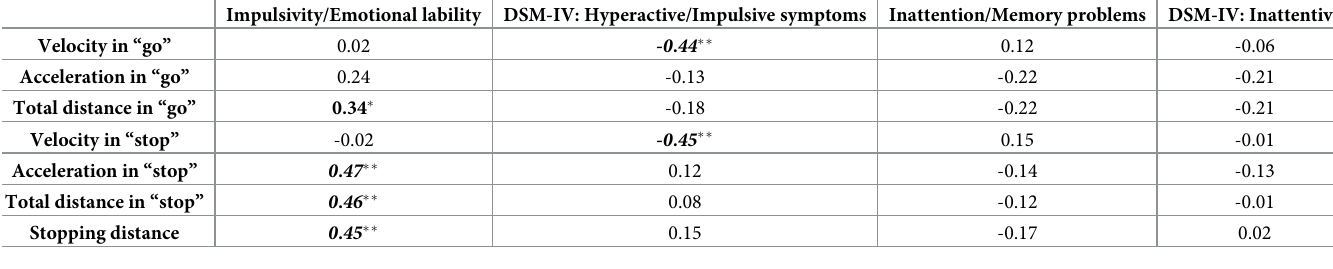
Table 7. Values of Spearman’s ρ for correlations between mouse movement and impulsivity/inattention measures at 50% coherency